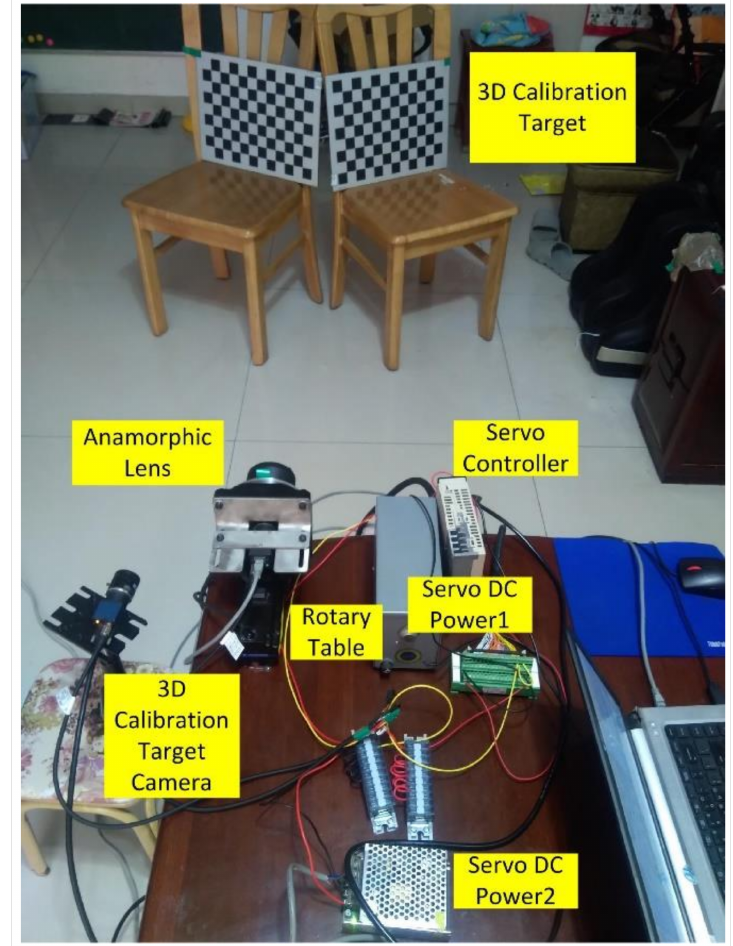
Figure 7. Experiment of 3D metrology using rotation anamorphic